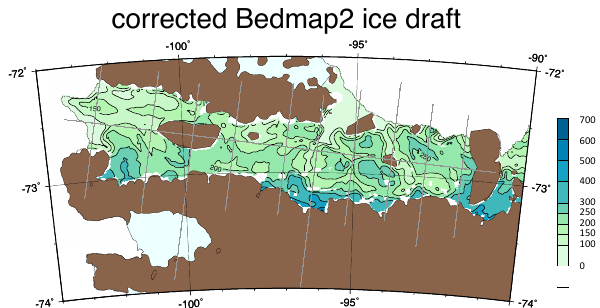
Fig. 8. Abbot Ice Shelf draft calculated from the 1km Bedmap2 compilation of surface elevation and ice thickness (Fretwell et al., 2013) corrected as discussed in the text and contoured at 100m in- tervals with 150 and 250m contours added. Grey lines show OIB flight lines. Color bar gives ice draft in